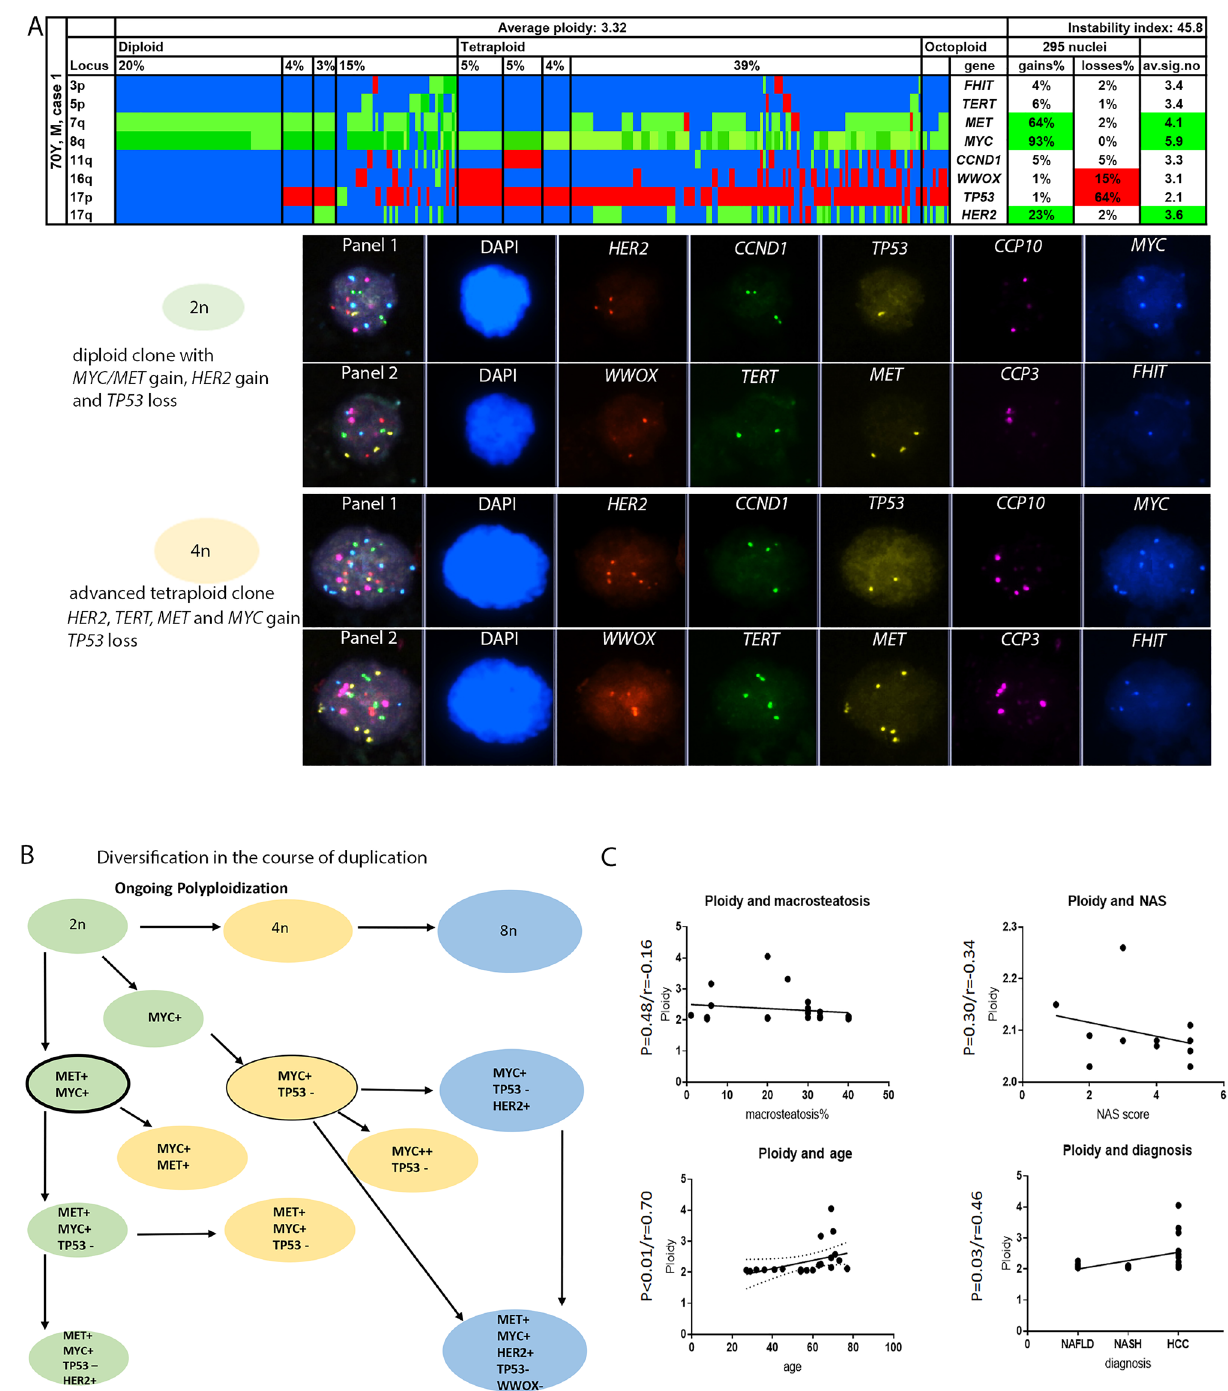
Figure 3. ( A – C ) Color display of miFISH analysis with eight gene-specific probes and gallery view summarizing a representative “evolving” nuclei showing genome duplication and additive genomic alterations of case 1. Green, gains; red, losses; blue, unchanged. Detail from left to right: the “locus” column shows the chromosome arm. Average ploidy (center) and percentages of tumor clones (top left to right) are grouped into diploid, tetraploid and octoploid tumor clones. High instability index (45.8), due to many different signal patterns/100 nuclei. ( A ) HCC case 1 with TP53 loss and MYC/MET and HER2 gain in diploid cells. Tetraploid cells also show TP53 loss and gains of MYC , MET, HER2 and additionally TERT . DUET/SOLO acquisition and analysis software version 3.7.2.5 https:// biovi ew. com/. ( B ) Schematic (condensed) tree of case 1, where diversification of tumor cell happens during polyploidization, see full FISH tree in Supplementary Fig. 2. ( C ) Correlations of histopathological findings and ploidy with respective p-and r-values (graphPad Prism software version 9.4.1 https:// www. graph pad. com/ scien tific- softw are/